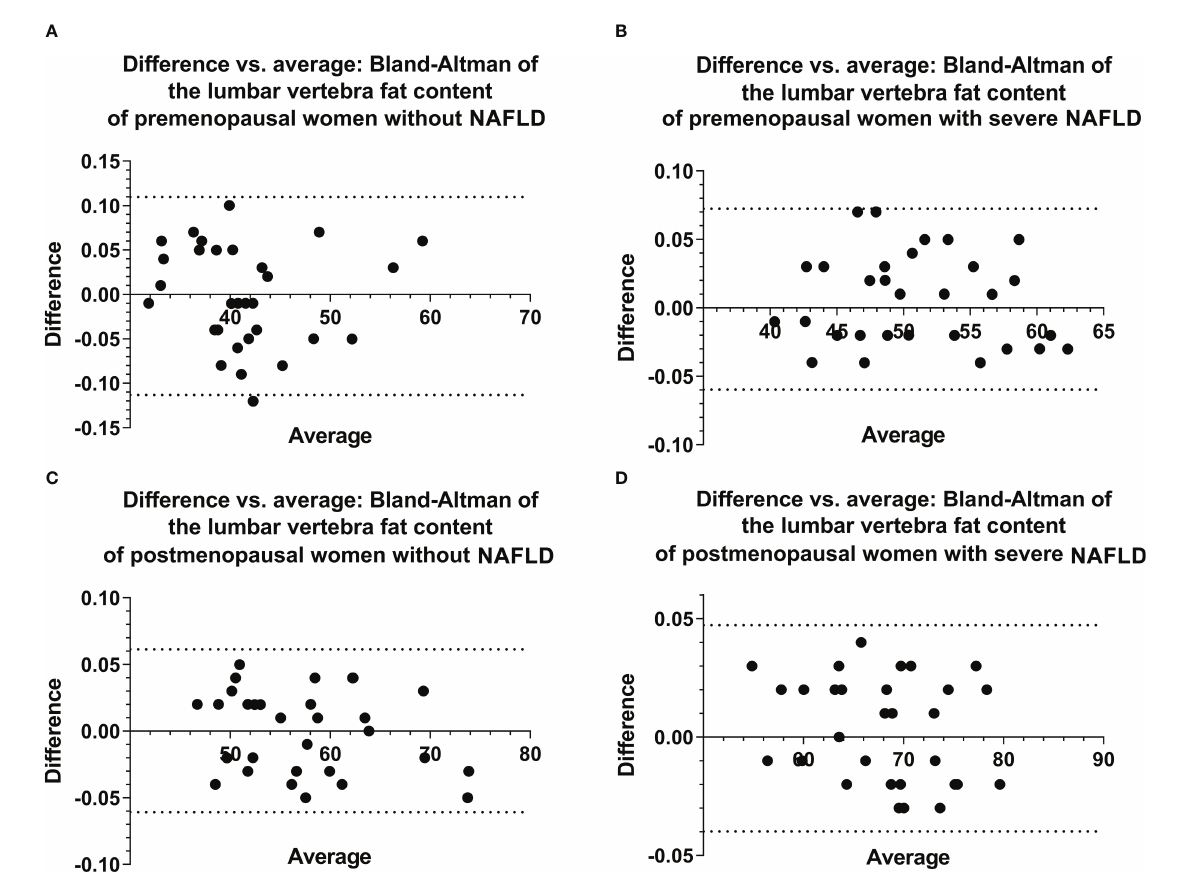
FIGURE 2 Bland – Altman plots of ROI-based FF values for the lumbar vertebra were obtained from two observations of the fi rst cohort (A – D) , showing excellent correlations, a negligible bias, and 95% limits of agreement of approximately ± 0.113 or less. ROI, region of interest, FF, fat